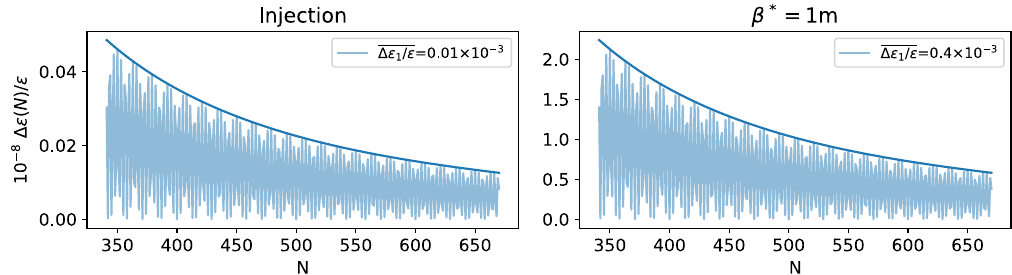
FIG. 9. Decay of the emittance growth with the length in turns (N) of the flux jumps effect on the magnetic flux itself, with an initial Δ ϵ = ϵ of 8 . 8 × 10 − 6 for injection and 4 × 10 − 4 for β (cid:1) ¼ 1 m (average of the values in Fig. 7). The clearer line shows the oscillating 1 decay as shown on Eq. (4) and the darker line shows the pessimistic envelope described in Eq. (5).